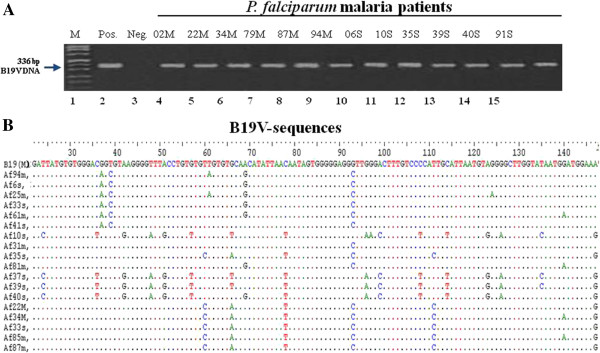
Qualitative assessment of B19V genomes in Gabonese children with P. falciparum. (A) Representative samples of the qualitative detection of B19V-DNA in serum of P. falciparum malaria patients using nPCR (lanes 4 to 15). DNA size marker, positive control, and negative control are shown in lane 1, 2 and 3, respectively. (B) B19V sequences of B19V-positive patients were aligned with reference B19V sequences using CLUSTALW (http://www.ebi.ac.uk/Tools/msa/clustalw2/), BioEdit (http://www.mbio.ncsu.edu/BioEdit), and GENEDOC_2.5 (http://www.psc.edu/biomed/genedoc) [GenBank accession No. genotype 1A: M13178, genotype 1B: DQ357064, genotype 2: AY064476 and AY044266; and genotype 3: AX003421, AY083234]. Sequence homologies are denoted as dots and nucleotide exchanges are shown in letters. The ruler at top of the sequences is numbered according to the B19V-NS1/VP1 sequences (nt 1 correspond to nt 2355).